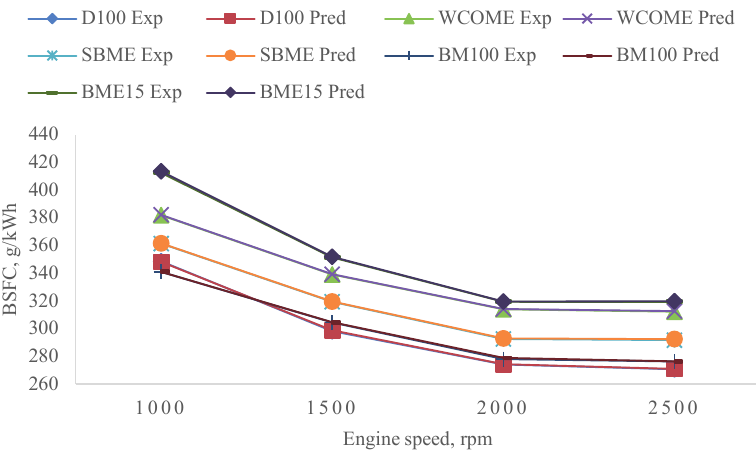
Fig. 3. Variation of brake specific fuel consumption with engine